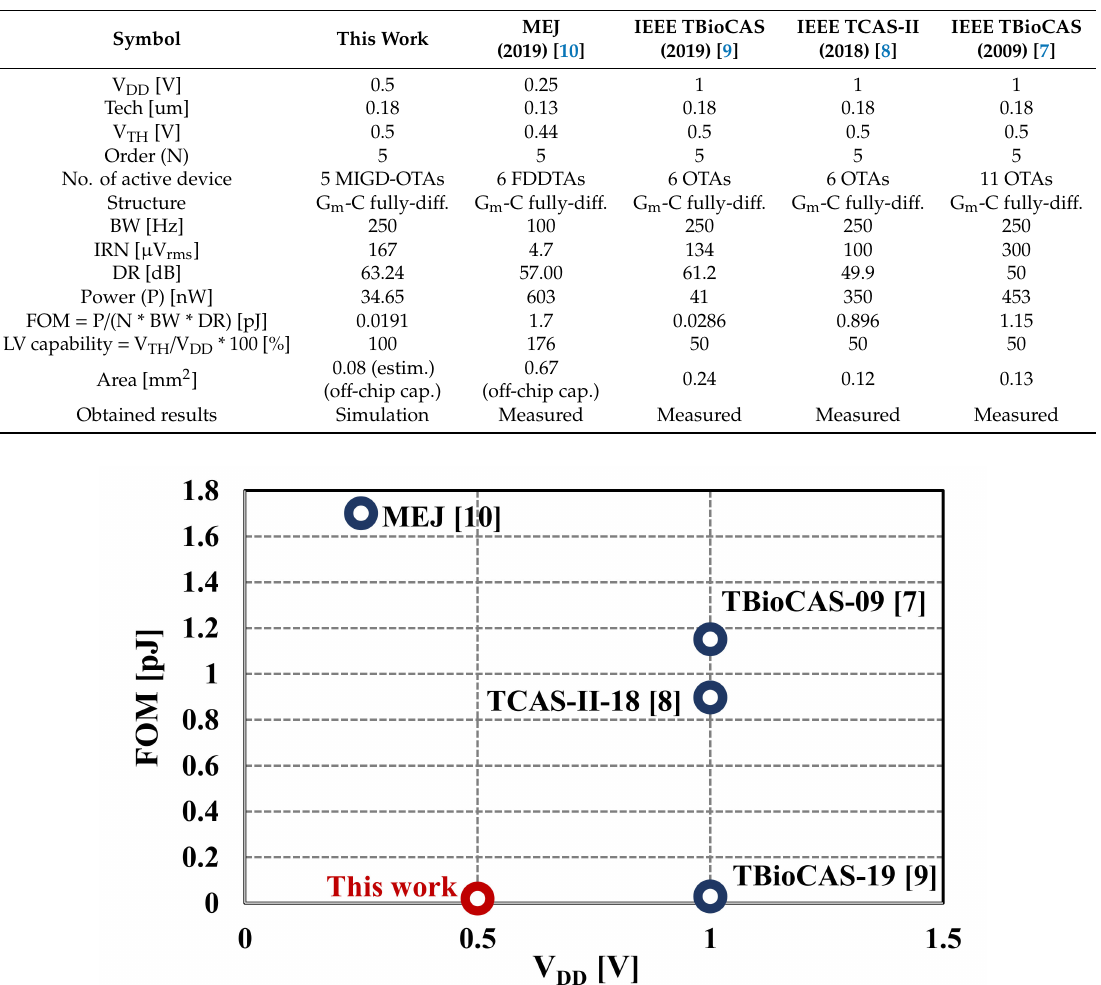
Table 1. Performance comparison between the proposed filter and other fifth-order low-pass filters for ECG signal acquisition.